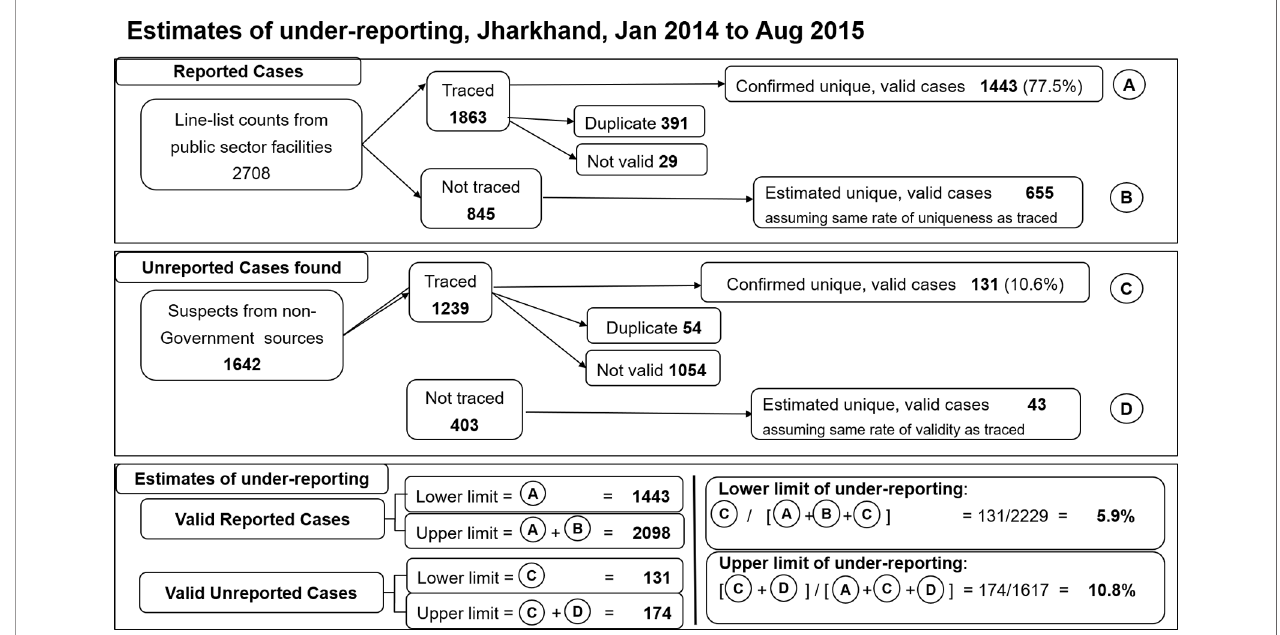
FIGURE 5 | Estimates of visceral leishmaniasis under-reporting, 4 endemic districts of Jharkhand, July 2013-December 2014. A total of 2708 cases were extracted from the line list of visceral leishmaniasis cases treated at public sector facilities during the study period, of which 1863 were traced and 1443 of those validated (A) . Assuming the untraced cases had the same rate of validity as the traced cases yields an additional 655 potentially valid cases (B) . From non-government sources 1642 suspected cases were identi fi ed, of which 1239 were traced and 131 validated as unreported cases (C) . Assuming the same rate of validity as for traced suspects yields 43 potentially valid unreported cases (D) . Based on these data, the validated case fi gure was estimated to range between 1443 and 2098 (A to A +B), while unreported case fi gure was between 131 and 174 (C to C+D). Using the extremes of these estimated ranges, underreporting was estimated between 5.9% and